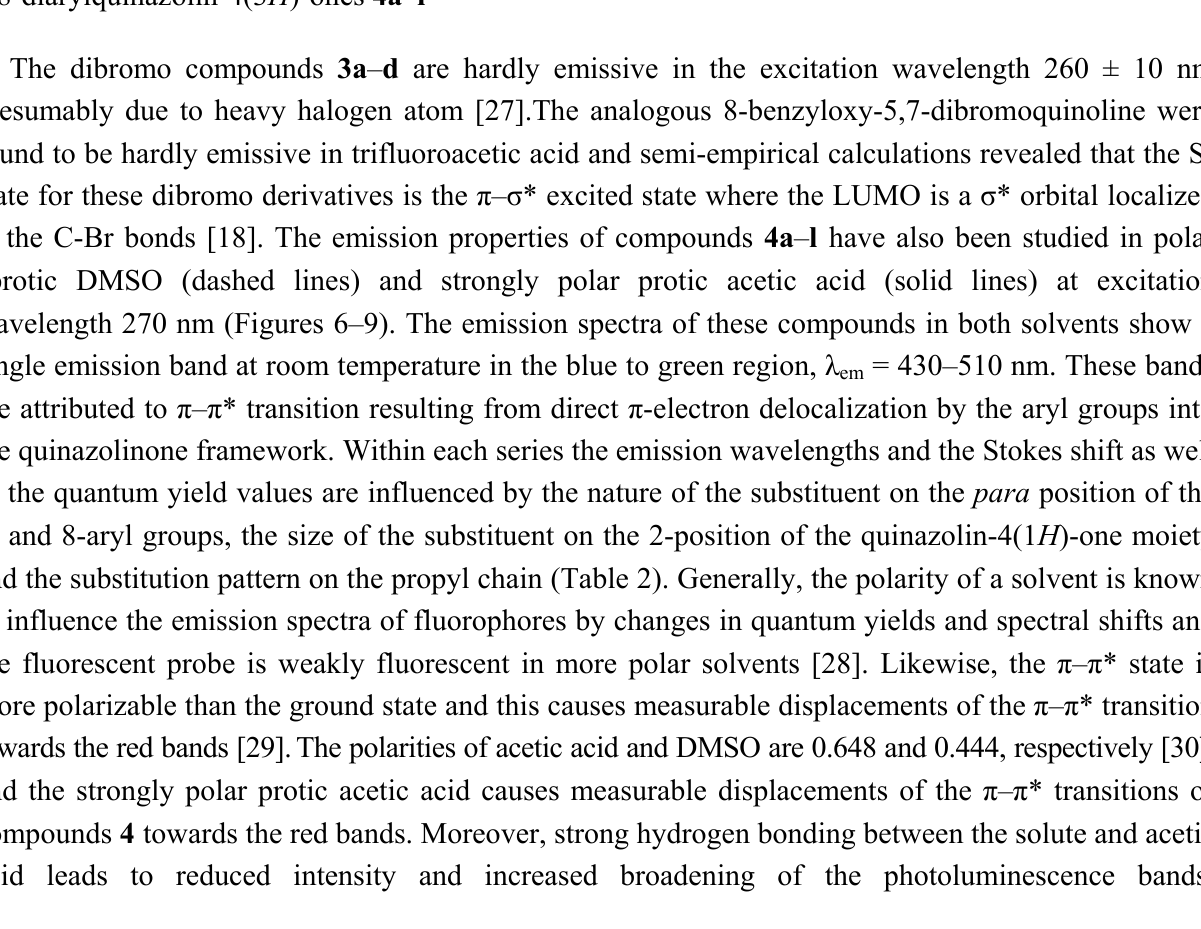
CO H (solid lines) at rt 3 2